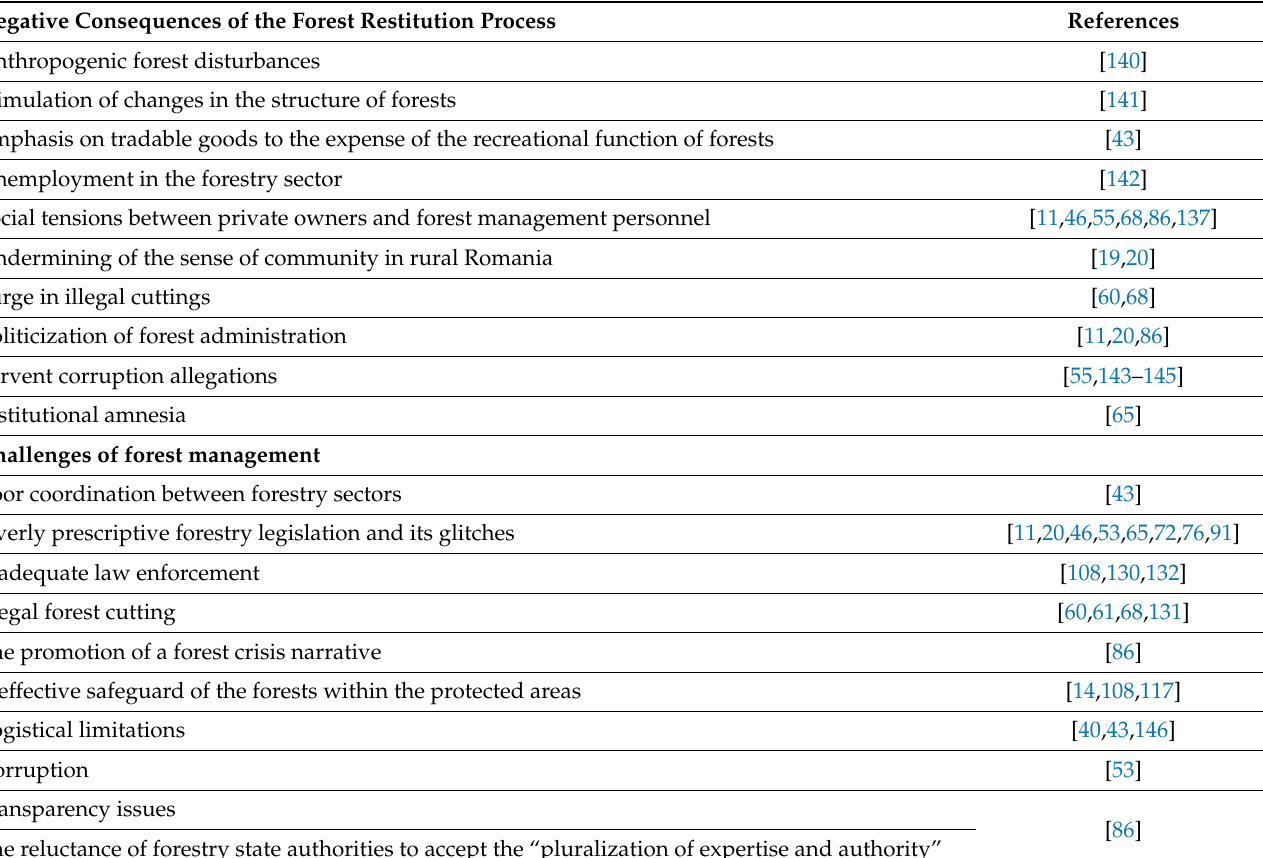
Table 2. The environmental, economic, and social impact of the forest restitution process and the challenges faced by Romanian forest